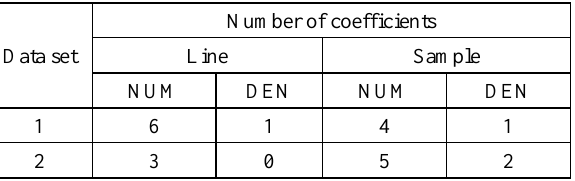
Table 3. Number of model’s parameters resulted from our